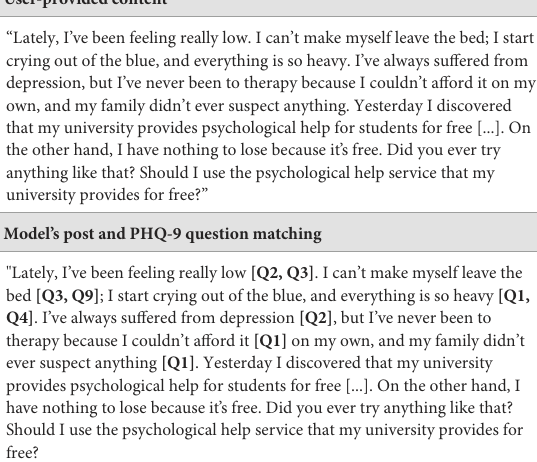
TABLE 7 The example in the table illustrate the simulated behavior. User-provided